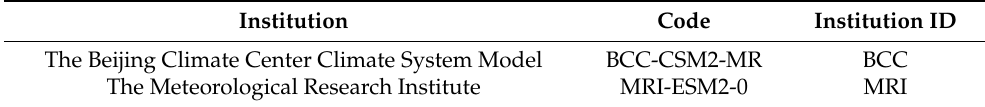
Table 2. The two future models used in the study.